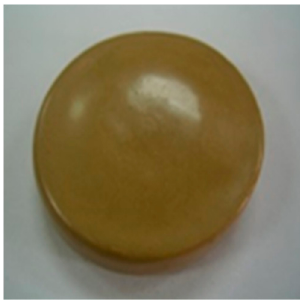
Figure 5. Color photograph of bloated iron-rich glass-ceramic sample as described in [14].